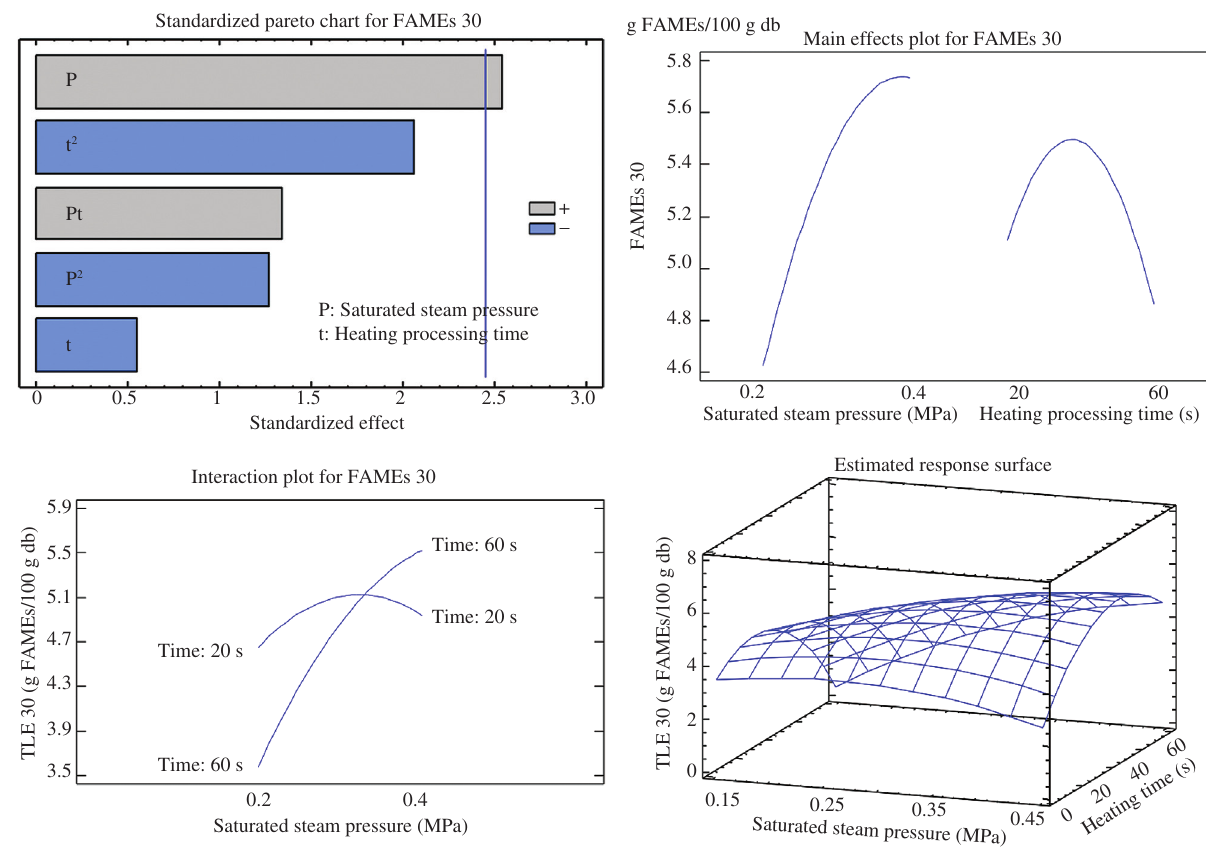
Figure 5 Pareto chart, general trends, cross effects and response surface of instant controlled pressure drop (DIC) operating parameter for fatty acid methyl esters (FAMEs) resulting from in situ transesterification of DIC-treated microalgae at initial water content of 30%